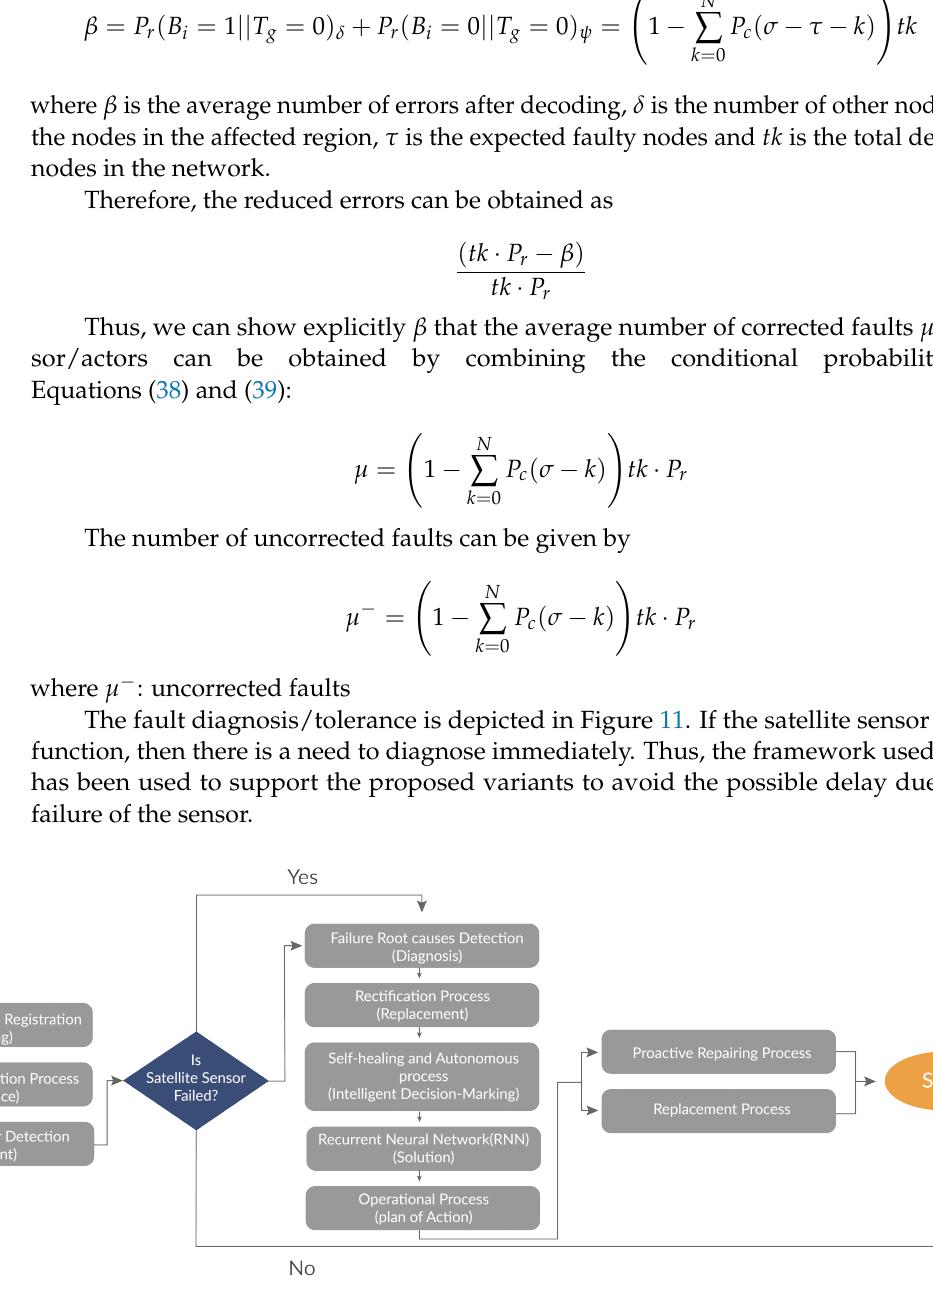
Figure 11. Fault Diagnosis/Tolerance process for Satellite Sensor for the